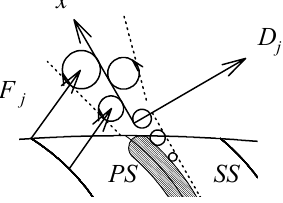
Fig.9 Karman vortex street in the wake of the